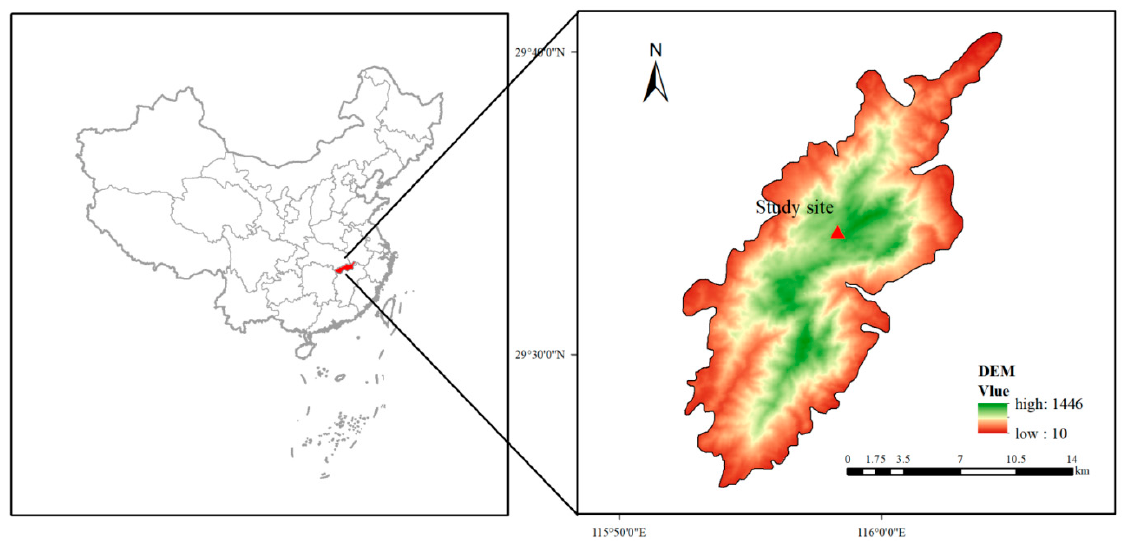
Figure 1. Location of the study